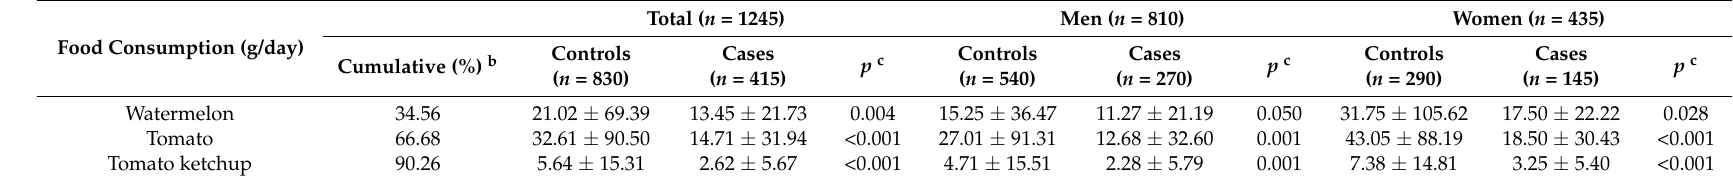
Table 6. Comparison of the consumption of lycopene contributing foods a .